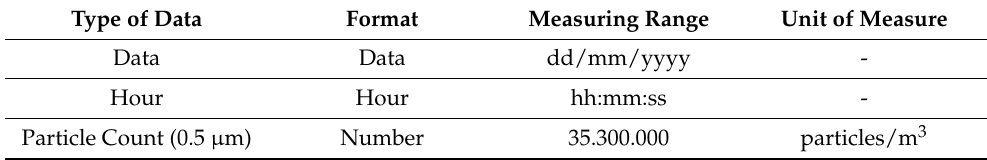
Table 2. Data collected by the particle counter.